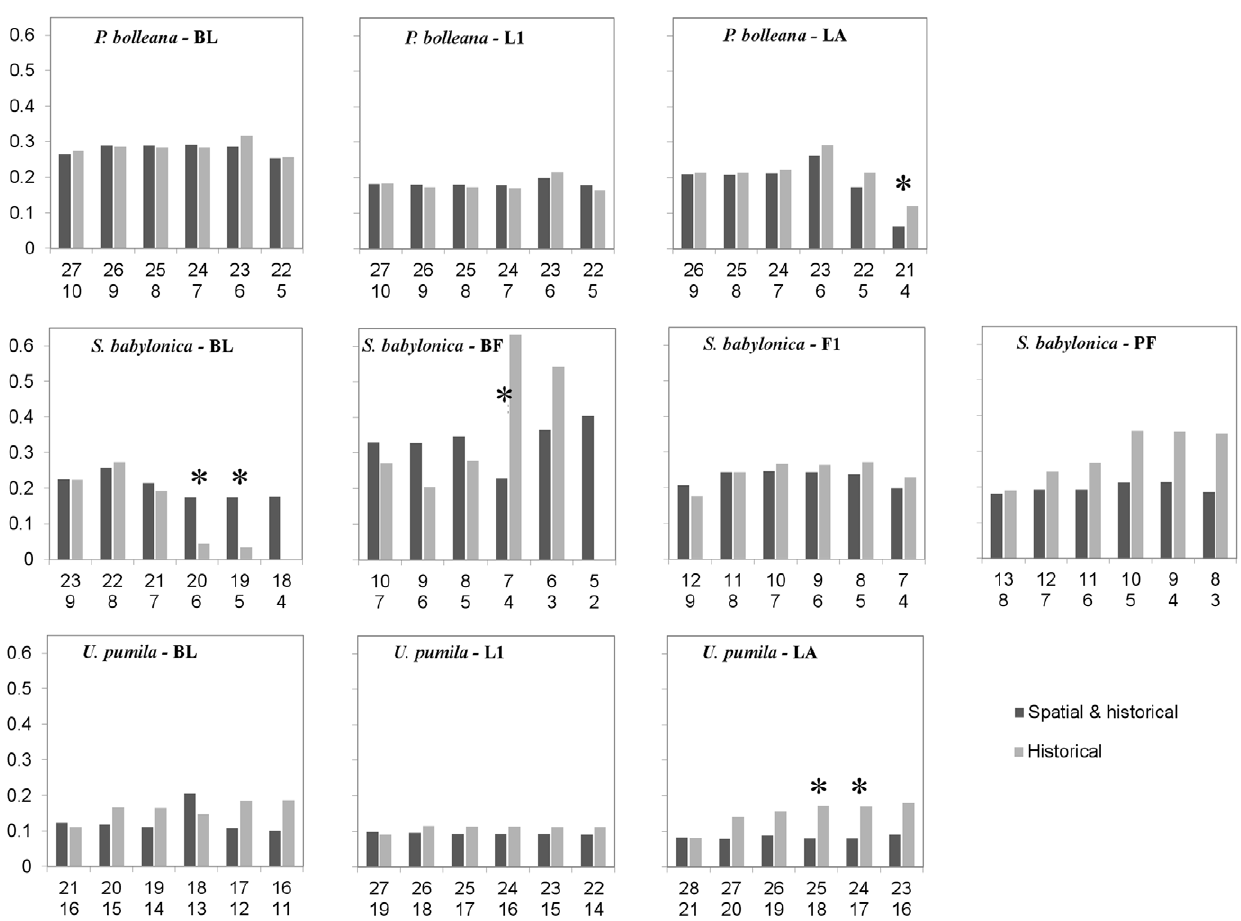
Figure 5. Absolute slopes (Y-axis) of linear fits to phenological time-series (1963–2009) predicted based on phenology regression models from combined data and those constructed from historical records. All slopes are negative and significant at p , 0.05. Numbers along the X-axis are sample sizes (top=combined and bottom=historical) used to develop phenology models. They decrease according to the elimination of one historical data point at a time, starting from the earliest. * indicate significance (p , 0.05) of slope difference based on ANCOVA analysis. Phenophases are same as in Table 1.